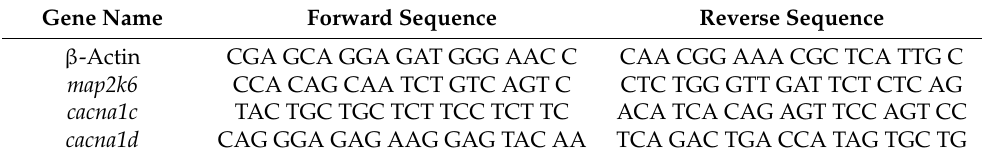
Table 1. Primers for